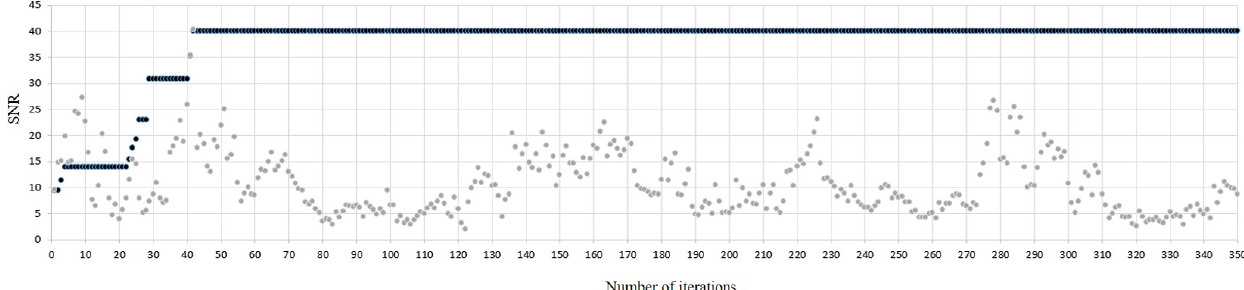
Figure 7. Build-up process of the EGF from cross-correlation functions by different methods: black dots – by SNR stacking; grey dots – by simple stacking.